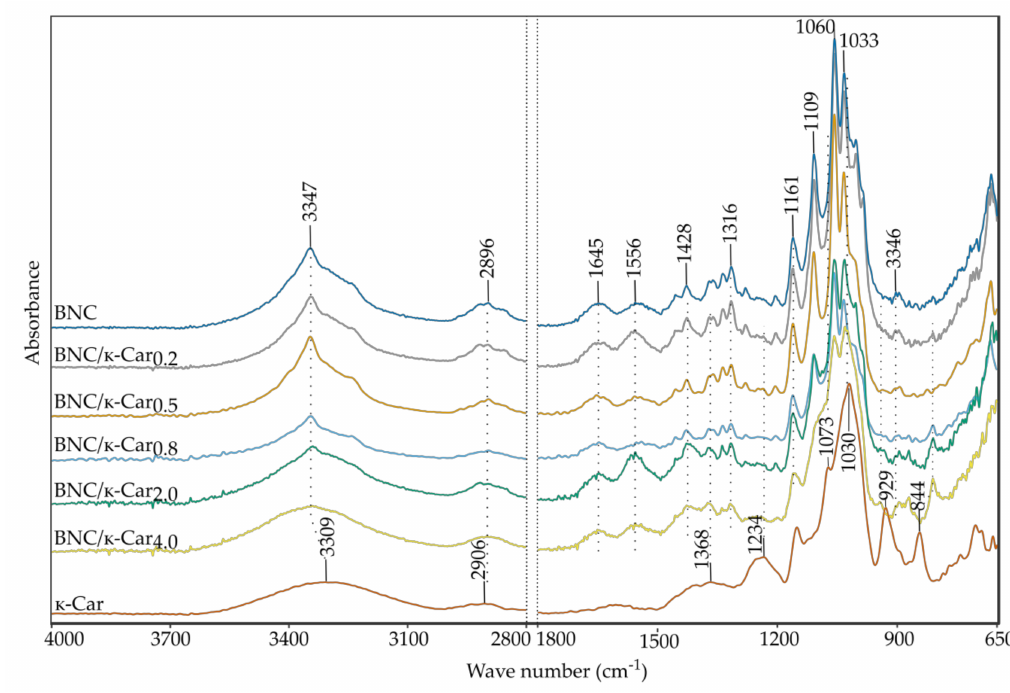
Figure 3. The Fourier-transform infrared spectroscopy (FTIR) spectra of BNC, κ -Car and BNC/ κ -Car composites at wave numbers ranging from 4000 to 650 cm − 1